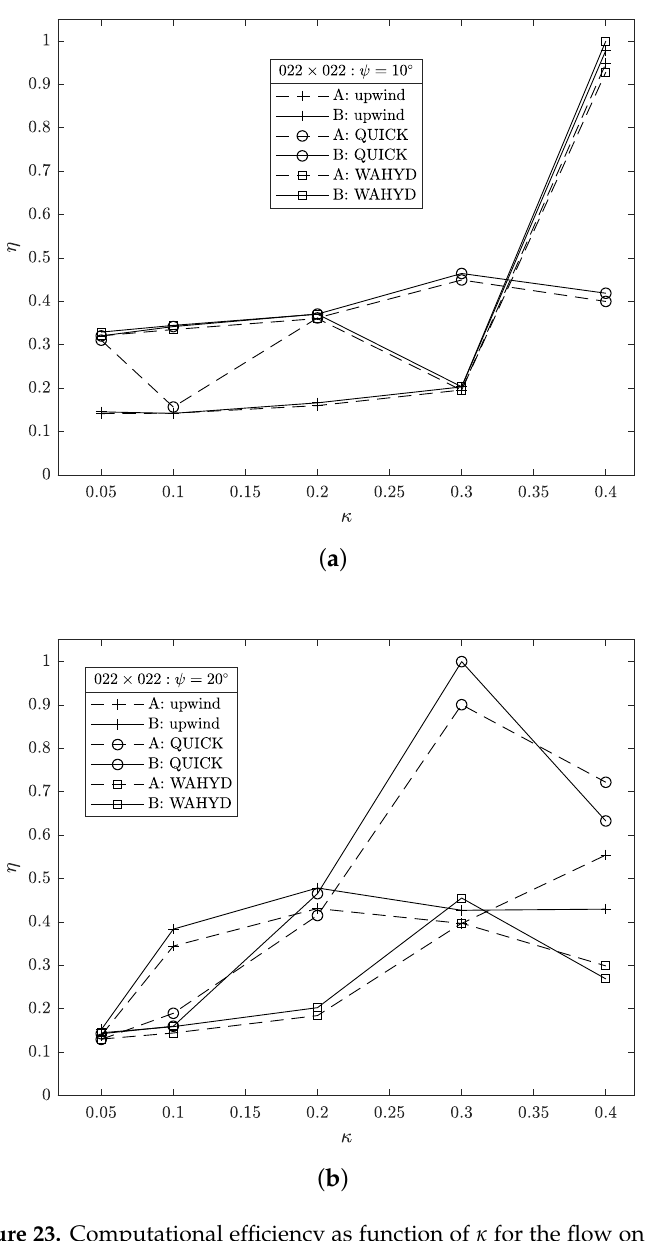
Figure 23. Computational efficiency as function of κ for the flow on a skewed-channel case using grid 22 × 22 and ψ : ( a ) 10º, ( b )